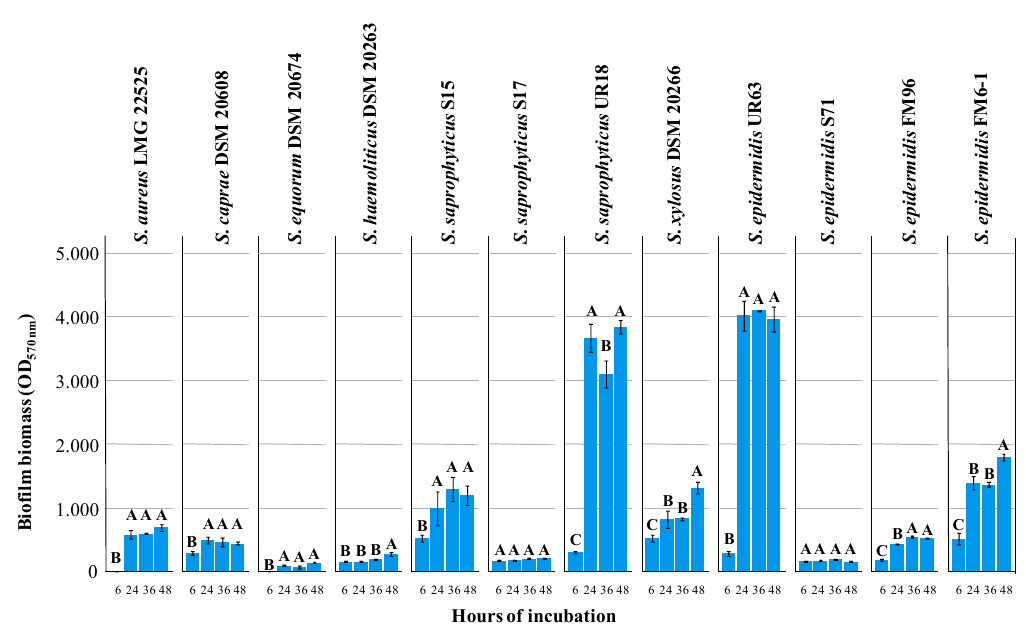
Figure 1. Biofilm biomass produced by Staphylococcus spp. strains, grown at 37 °C in TSBG after 6, 24, 36, and 48 h. Values represent the mean ± standard deviation ( n = 4) and were determined by measuring the absorbance of Crystal Violet (CV) at 570 nm [36]. For each assayed strain values with different letters are significantly ( p < 0.05) different among days of incubation according to HSD Tukey’s post hoc test.